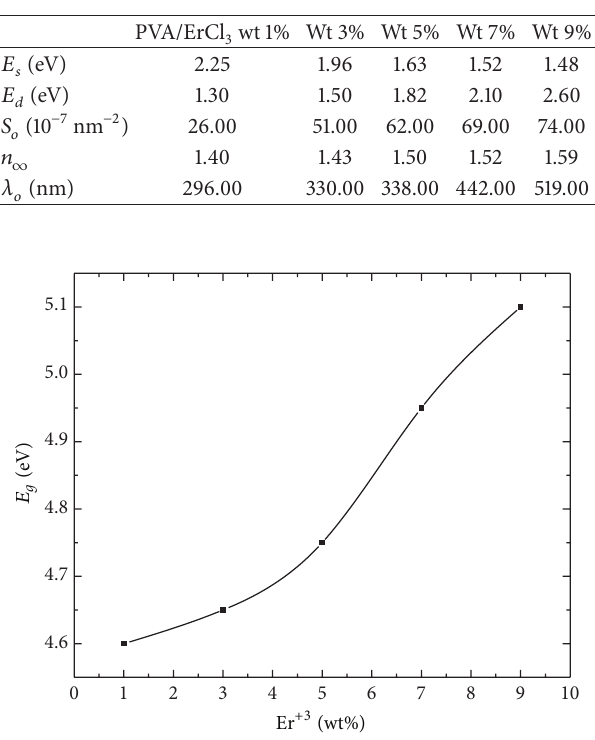
Figure7:EnergygapvariationineVwiththedopingconcentrations of ErCl 3 within PVA samples.